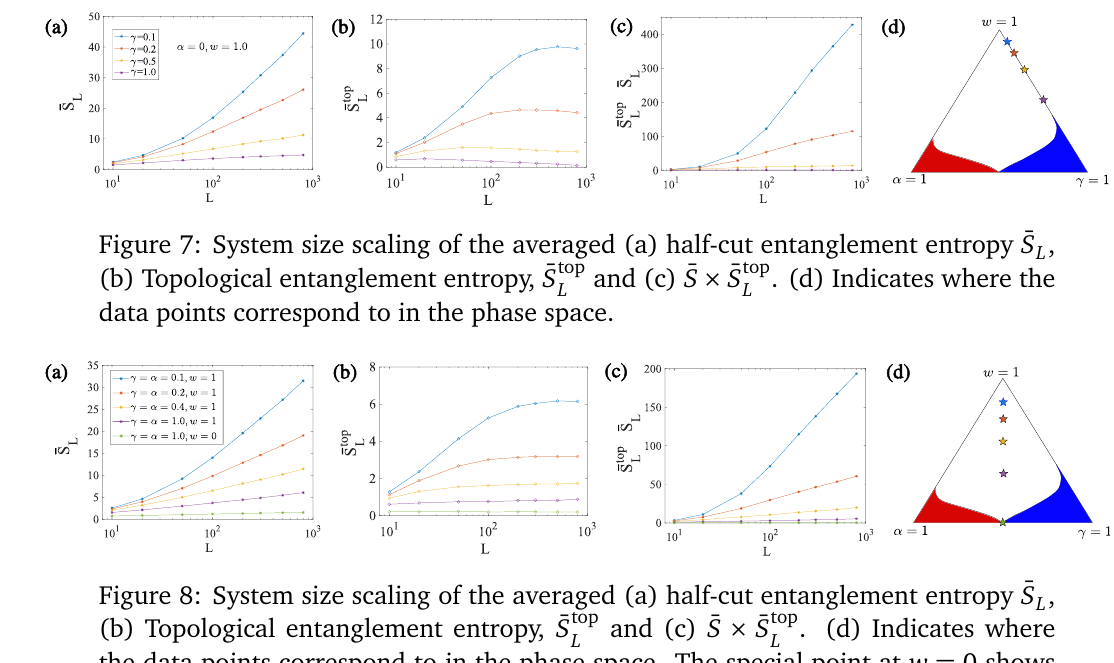
, L and (c) ¯ S × ¯ S top . (d) Indicates where L L